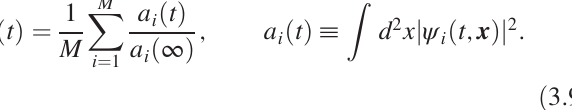
and equilibration time freeze (B15). For rapid c scaling. Right: t also eq Q scaling, consistent with Q